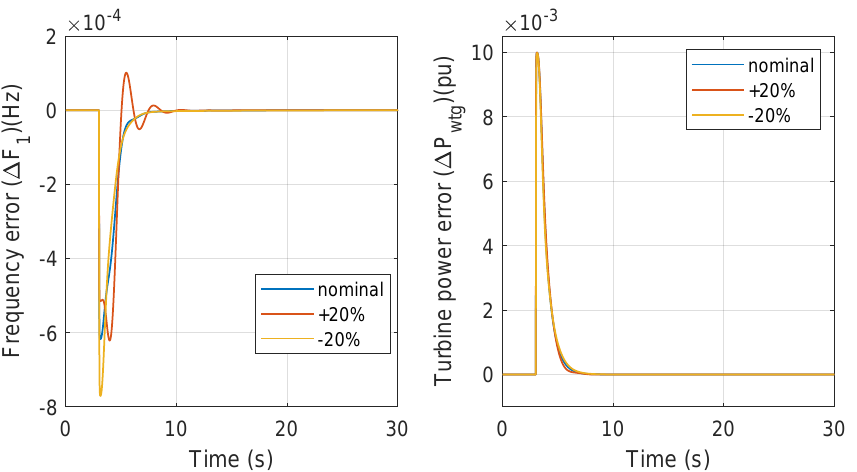
Figure 9. Robust performance of the frequency and turbine power error in the first and second subsystems against ± 20% concurrent changes in all subsystems parameters for the proposed decen- tralized MPC controllers, subject to the load disturbance applied at t = 3 (s) with the amplitude of 0.01